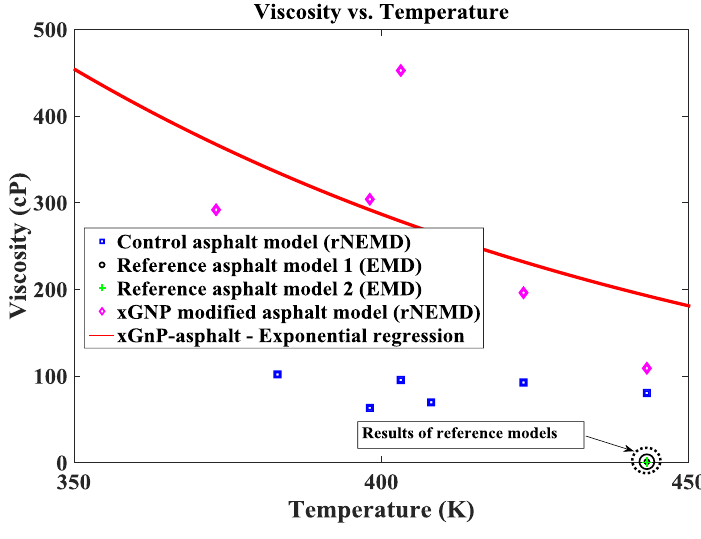
Figure 8. MD viscosity results of the control and xGNP modified asphalt binder systems.